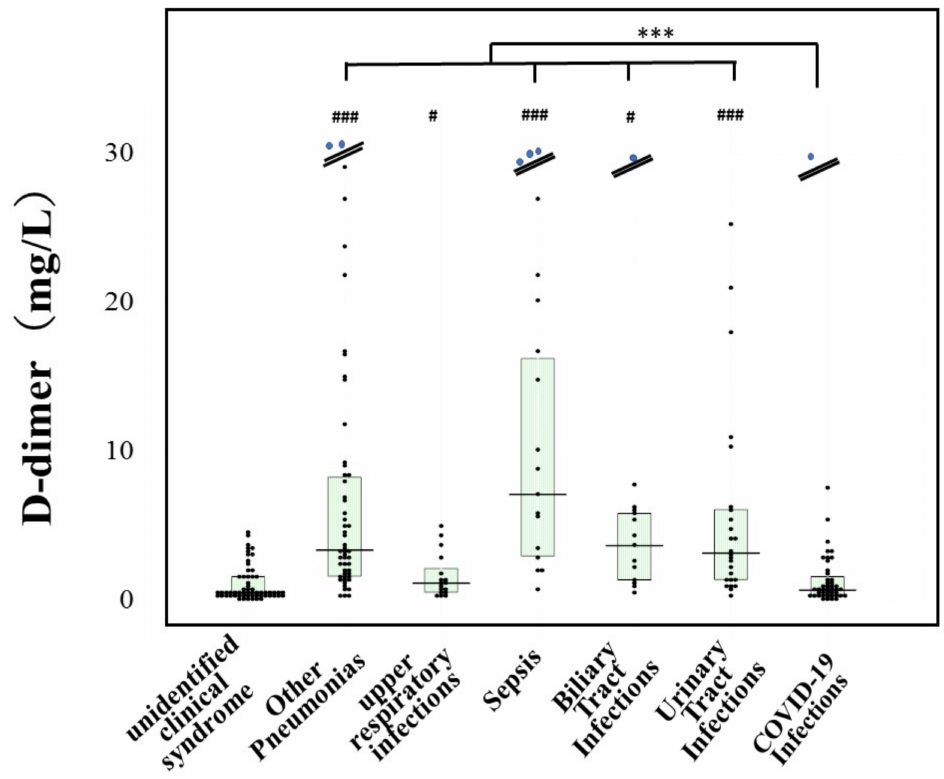
Figure 1. Plasma levels of D-dimer in various infections and COVID-19 infection. ***, p < 0.001 in comparison with COVID-19 infection; # , p < 0.05 in comparison with unidentified clinical syndrome; ### , p < 0.001 in comparison with unidentified clinical